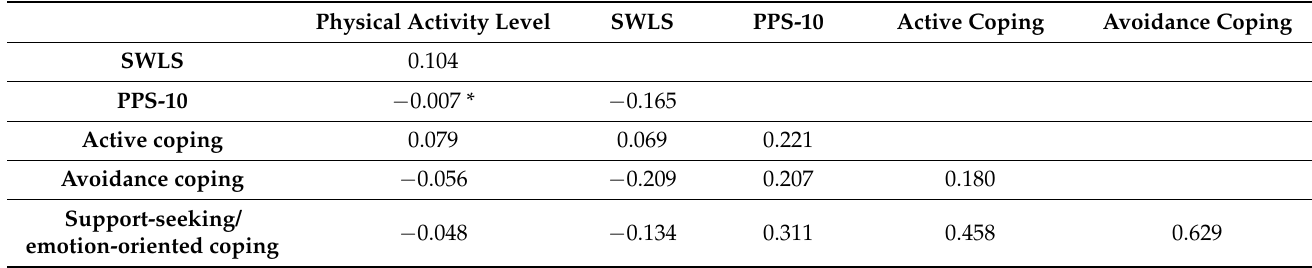
Table 7. Pearson’s correlation coefficients between of the main diagnostic indicators.